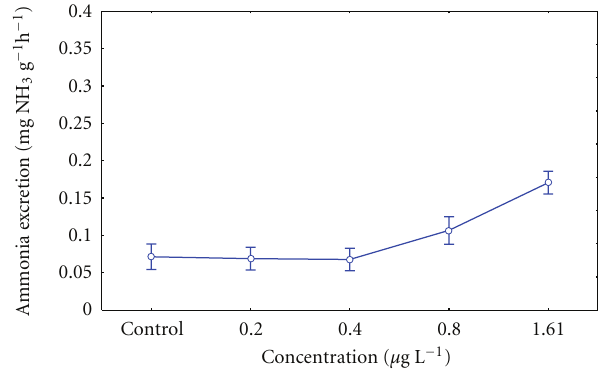
Figure 3: Ammonia excretion on Aulacomya ater in control and exposed sublethal concentrations of organophosphate pesticide. Mean values with standard error plotted ( ∗ statistical di ff erence P < 0 . 05).